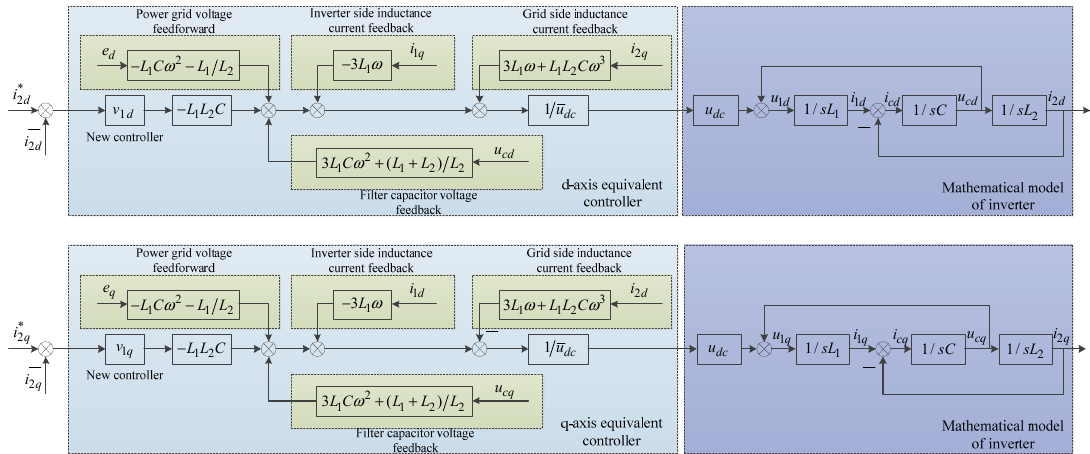
Figure 2. Current control system based on state feedback linearization.